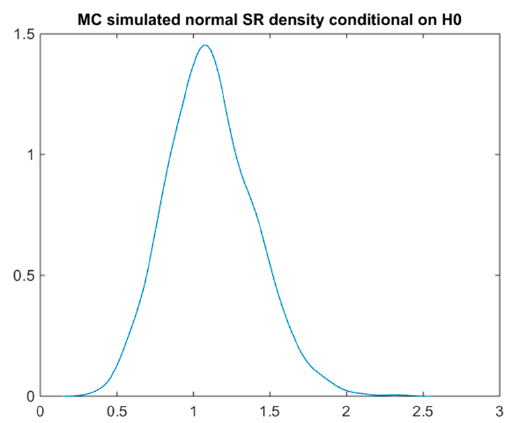
Figure 6. Sharpe ratio’s probability density according to the null hypothesis and the multivariate normal MC simulation.